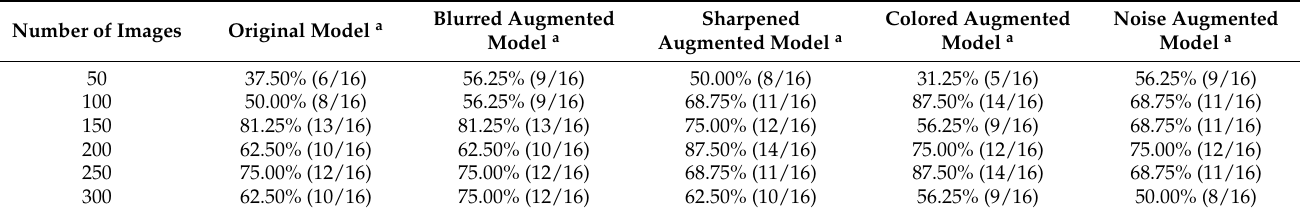
Table 3. The cross-sectional detection of each model.